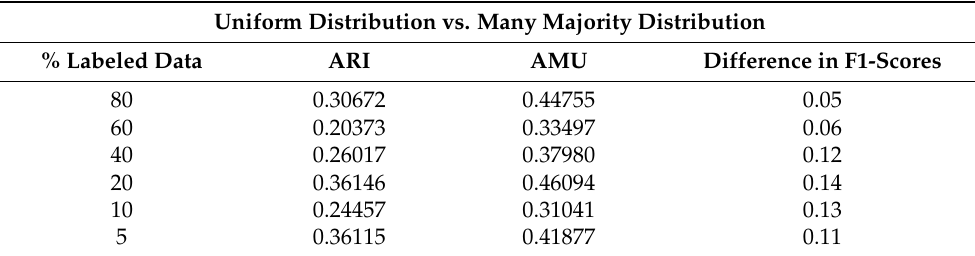
Table 14. ARI, AMU and difference in F1-scores for uniform distribution vs. many majority distribution. Uniform Distribution vs. Many Majority Distribution